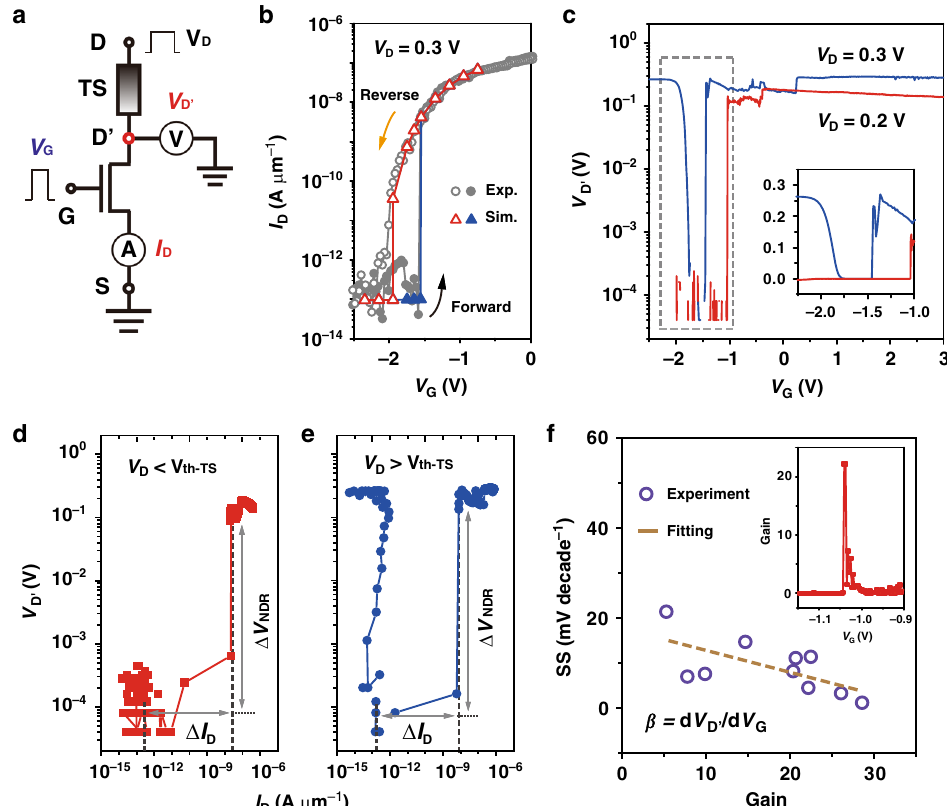
Fig. 4 ATS-FET with an internal ampli fi cation across the MoS 2 channel. a The equivalent circuit schematic for the electrical measurements. V D ′ and I D in red are the output parameters that need to be simultaneously recorded with the increase of the input V G (blue). b The experimental and simulated transfer ( I D – V G ) characteristics of the ATS-FET at V D = 0.3 V, indicating the simulated results are in good agreement with the experimental data. c The relations between the gate voltage ( V G ) and the internal voltage ( V D ′ ) for two V D schemes, including V D ( = 0.2 V) < V th-TS and V D ( = 0.3 V) > V th-TS . The inset is the linear scale from the data shown in the dashed grey rectangle. d , e V D ′ changes as a function of I D for the two V D schemes. The NDR effect induces an ampli fi cation of V D ′ across the MoS 2 channel. f The relation between the average SS and the internal ampli fi cation gain ( β = d V D /d V G ). The inset indicates the sharp increase in V D ′ with respect to the applied V G occurring in the region of the abrupt switching due to the NDR